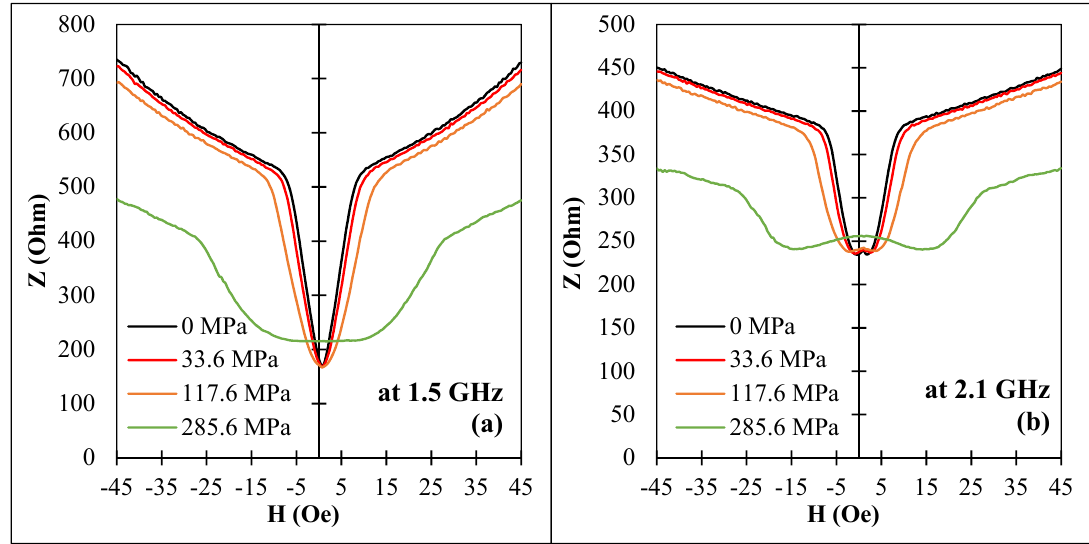
Figure 11. Effect of a tensile stress on the MI vs. magnetic field plots for amorphous Co 66.6 Fe 4.28 B 11.51 Si 14.48 Ni 1.44 Mo 1.69 microwires (sample No1) in as-cast state at frequencies: ( a ) 1.5 GHz and ( b ) 2.1 GHz. Z corresponds to the impedance am- plitude.